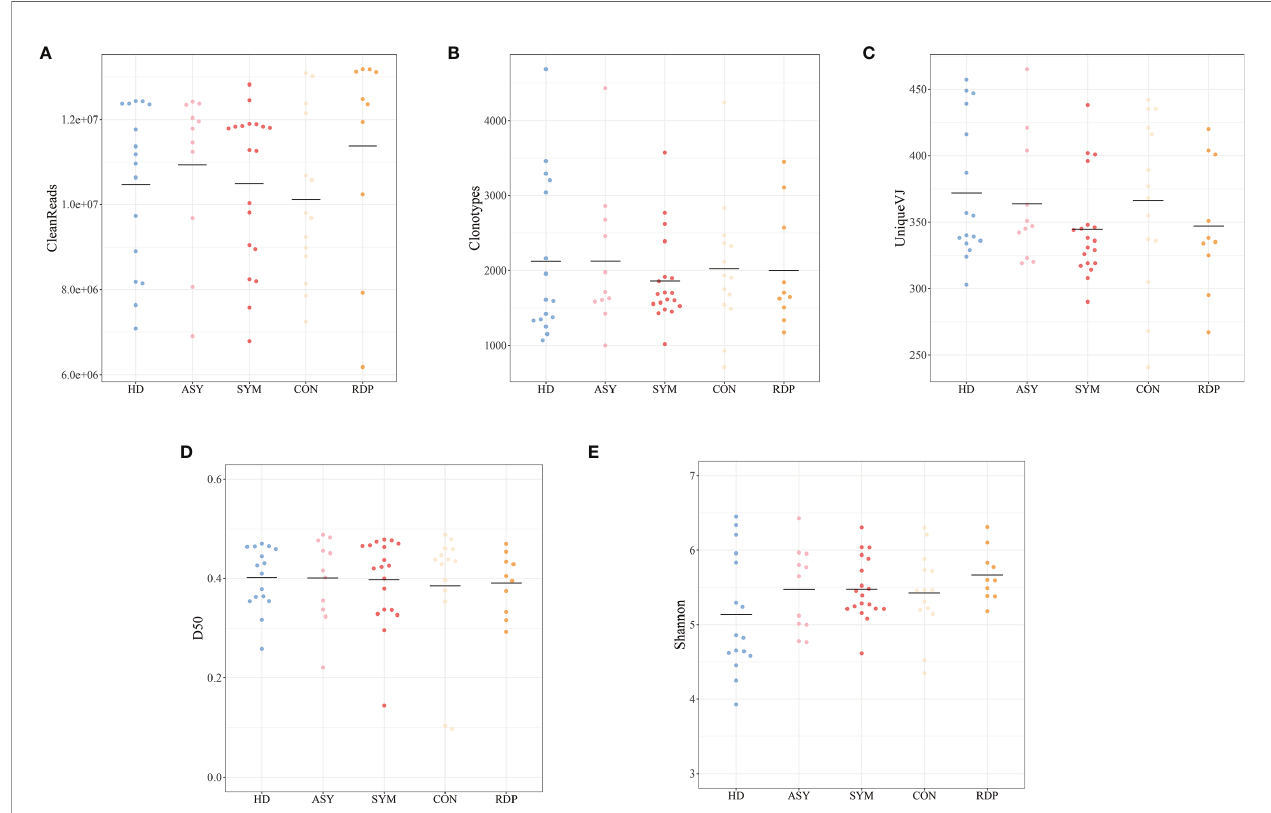
FIGURE 2 | Analysis of data quality and overall clonal diversity among different groups. (A) The number of clean reads. (B) The number of clonotypes. (C) The number of unique VJ pairs. (D) Distribution of D50 index. (E) Distribution of Shannon